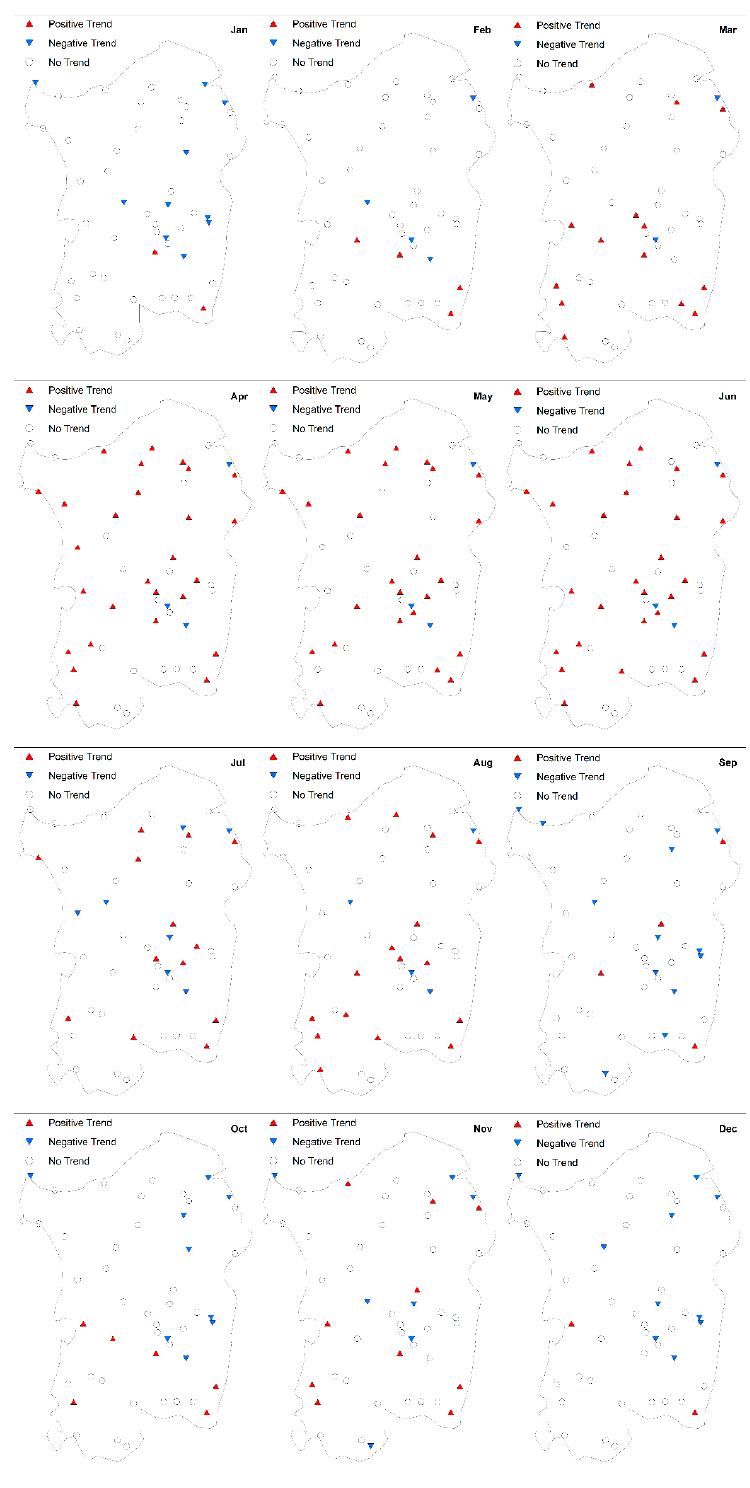
Figure 5. Spatial distribution of monthly maximum temperature trend.